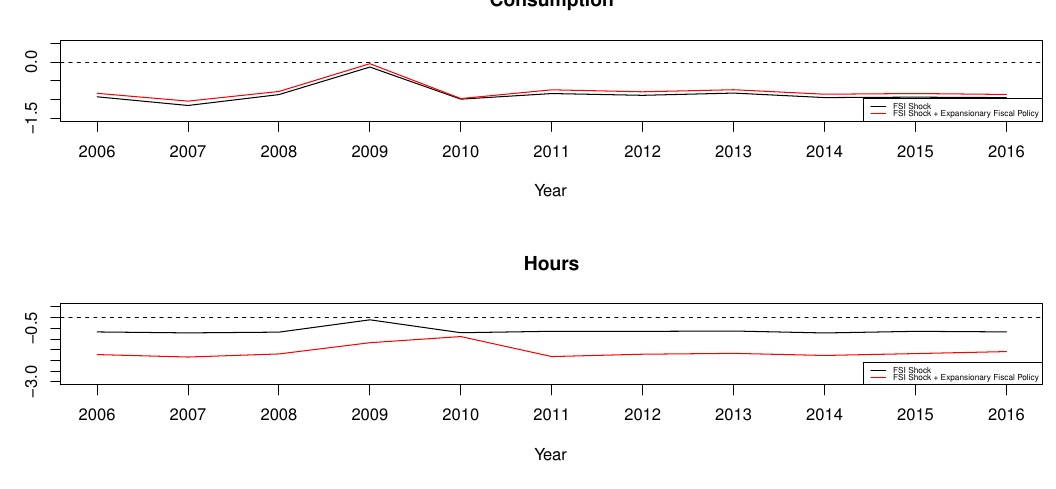
Figure 2. Effects of FSI Shock on consumption and working